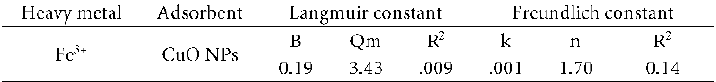
Table 3. mathematical parameters obtained from the isotherm models.